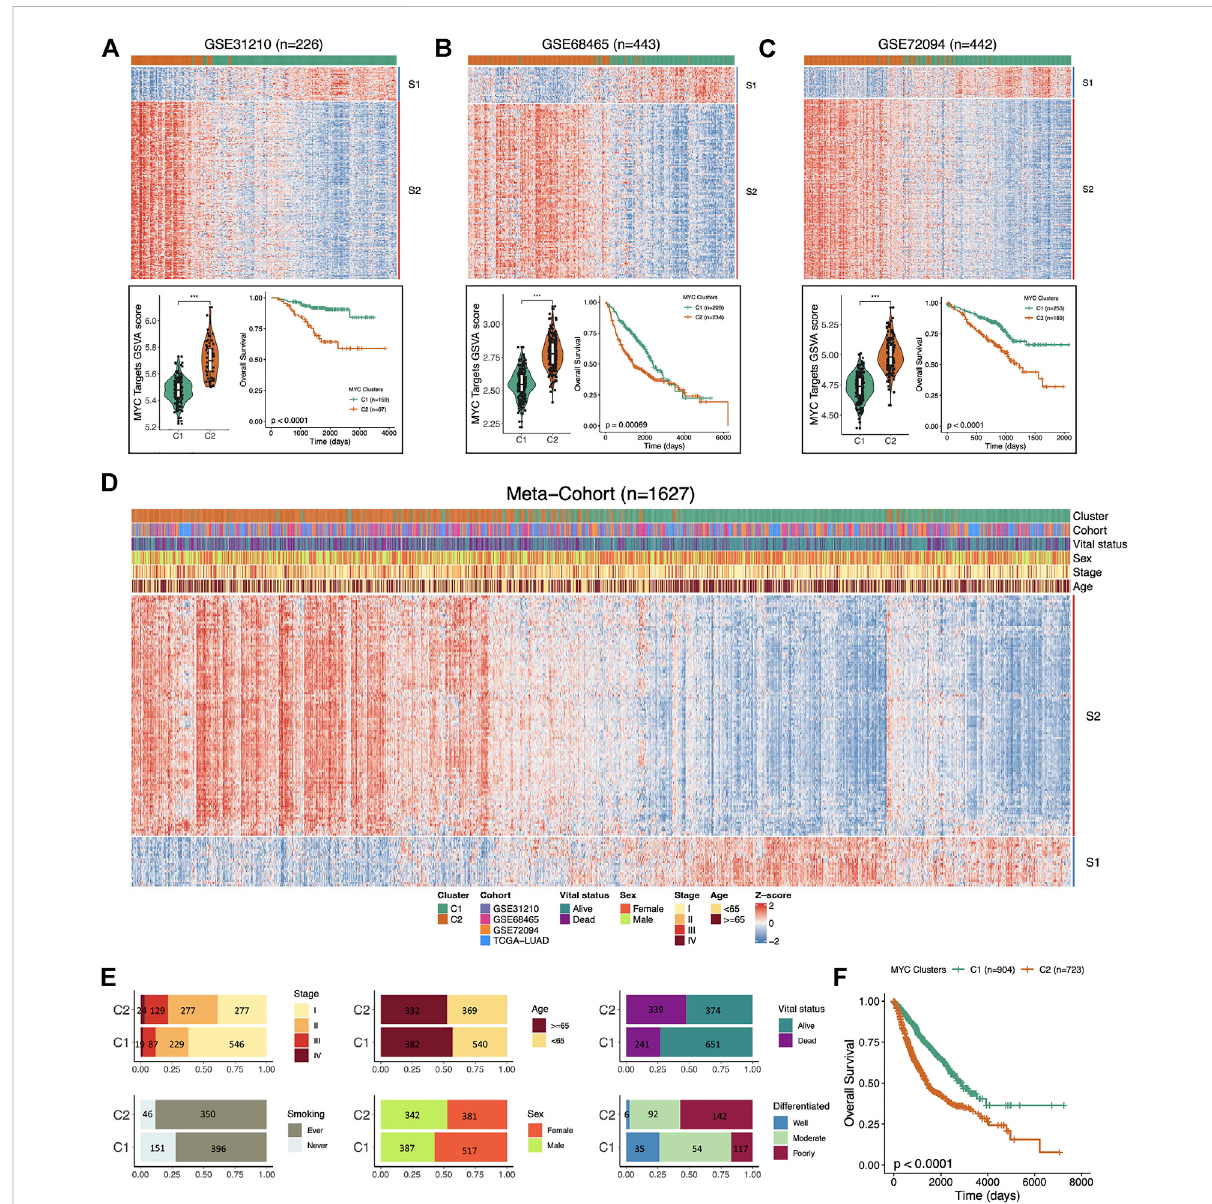
FIGURE 5 Independent validation of MYC-signaling grouping and prognosis. (A) The upper part the heatmap showing the expression distribution of the SignaturegenesbetweenthetwoclustersinGSE31210.TheLowerpart:comparisonofMYCTargetGSVAscoresbetweenthetwodistinctsubgroups (C1 and C2) in GSE31210 (right); Comparison of overall survival (OS) between C1 and C2 in GSE31210 (left). (B) The upper part: the heatmap showing the expression distribution of the Signature genes between the two clusters in GSE68465. The Lower part: comparison of MYC Target GSVA scores between the two distinct subgroups (C1 and C2) in GSE68465 (right); Comparison of overall survival (OS) between C1 and C2 in GSE68465 (left). (C) The upperpart:theheatmap showingtheexpressiondistribution oftheSignature genesbetweenthetwoclustersinGSE72094.TheLower part: comparison of MYC Target GSVA scores between the two distinct subgroups (C1 and C2) in GSE72094 (right); Comparison of overall survival (OS) between C1 and C2 in GSE72094 (left). (D) The expression trend of signature genes and the distribution of the clinical characteristics of LUAD patients in the C1 and C2 in the meta-cohort (n = 1,627). (E) The distribution of the clinical characteristics (stage, smoking, age, sex, vital status, and grade) of LUAD patients in the C1 and C2. (F) Comparison of overall survival (OS) between C1 and C2 in the